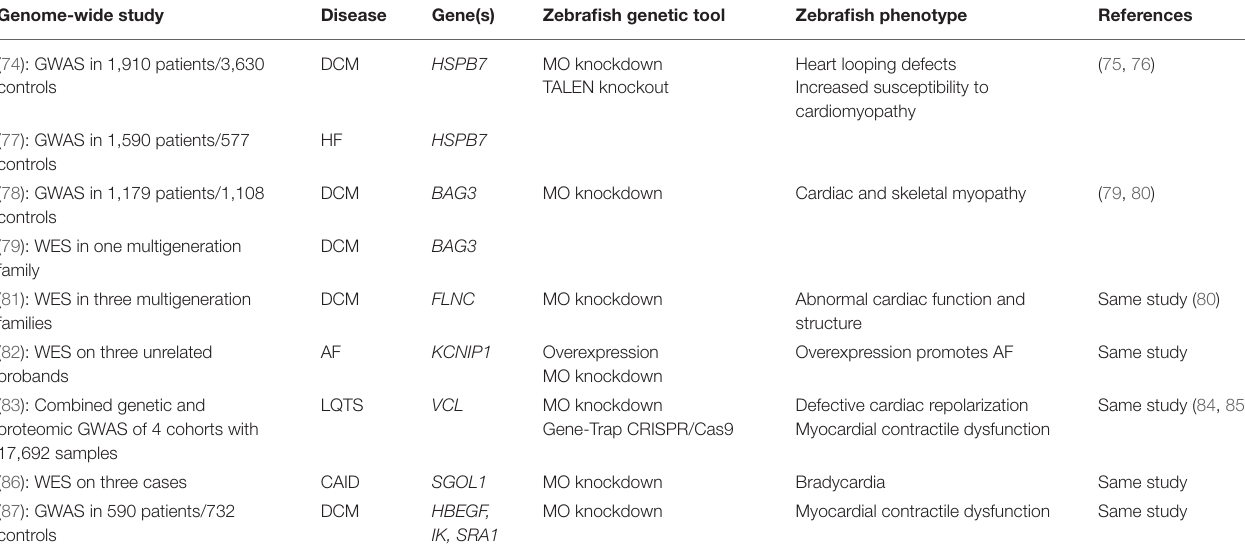
TABLE 1 | Genome-Wide Studies using the zebrafish model to validate the causality of candidate genes. Genome-wide